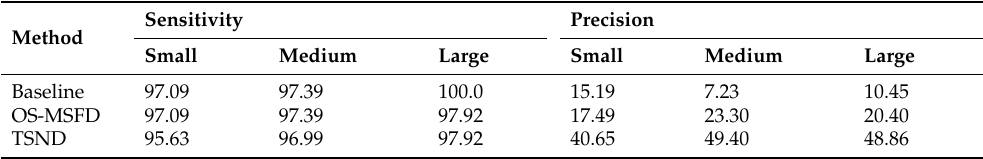
Figure 12. The distribution of missed nodules of different sizes for three methods. Table 5. Comparison of the detection sensitivity(%) and precision(%) of three proposed methods: Baseline, OS-MSFD, and TSND for nodules of different